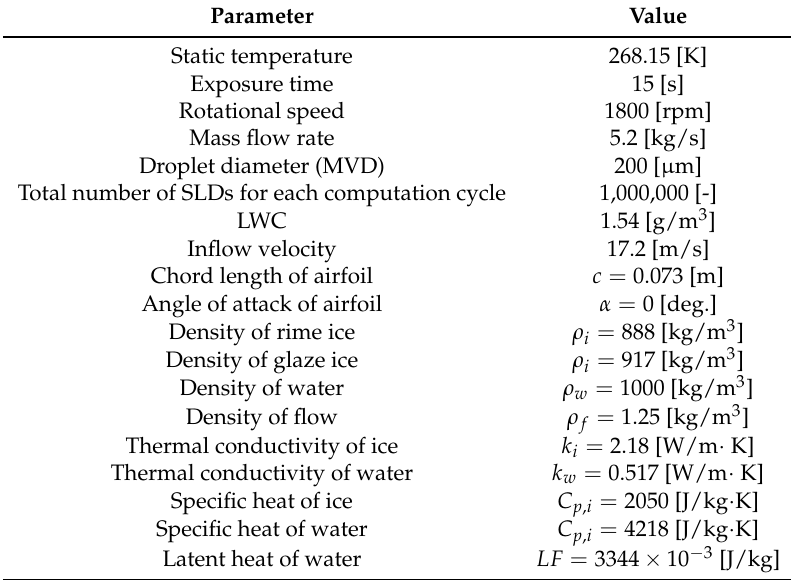
Table 3. Numerical conditions for the axial fan icing simulation.